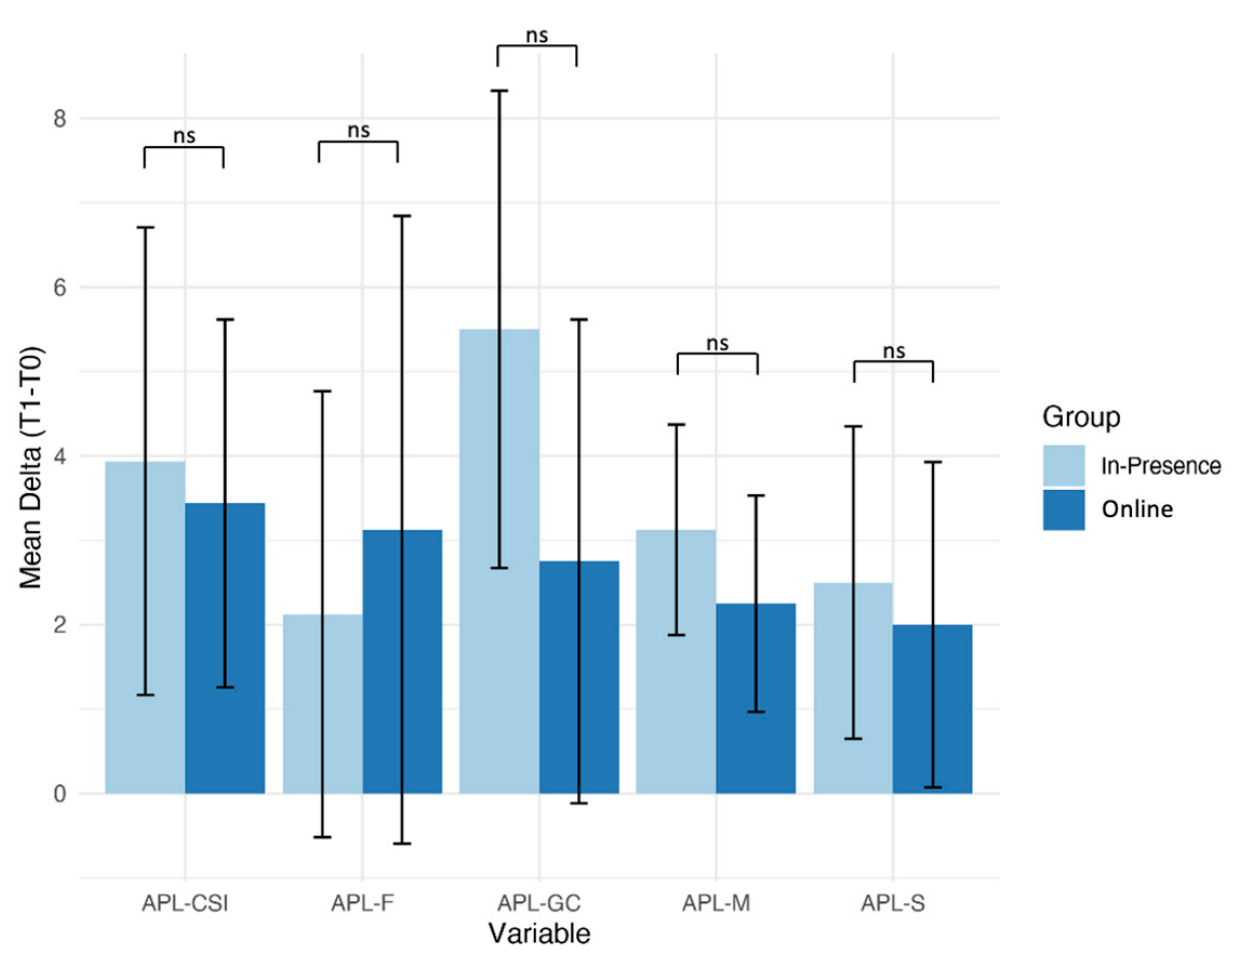
Figure 2. Mean Delta values (T1 − T0) for each APL subtests in the two groups. Behavioral changes before and after treatment were calculated as the delta-values. Online training: Experimental group; In-presence: Control group. Error bars represent the SD. ns: no significant.